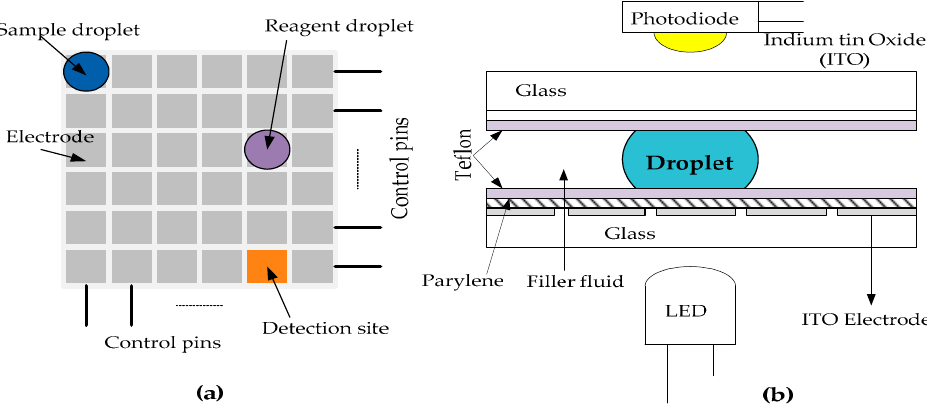
Figure 1. The schematic view of a DMFB ( a ) Top view of a digital microfluidic biochip system, ( b ) Cross-section view of the digital microfluidic system showing the sandwiched droplet between the parallel plates.